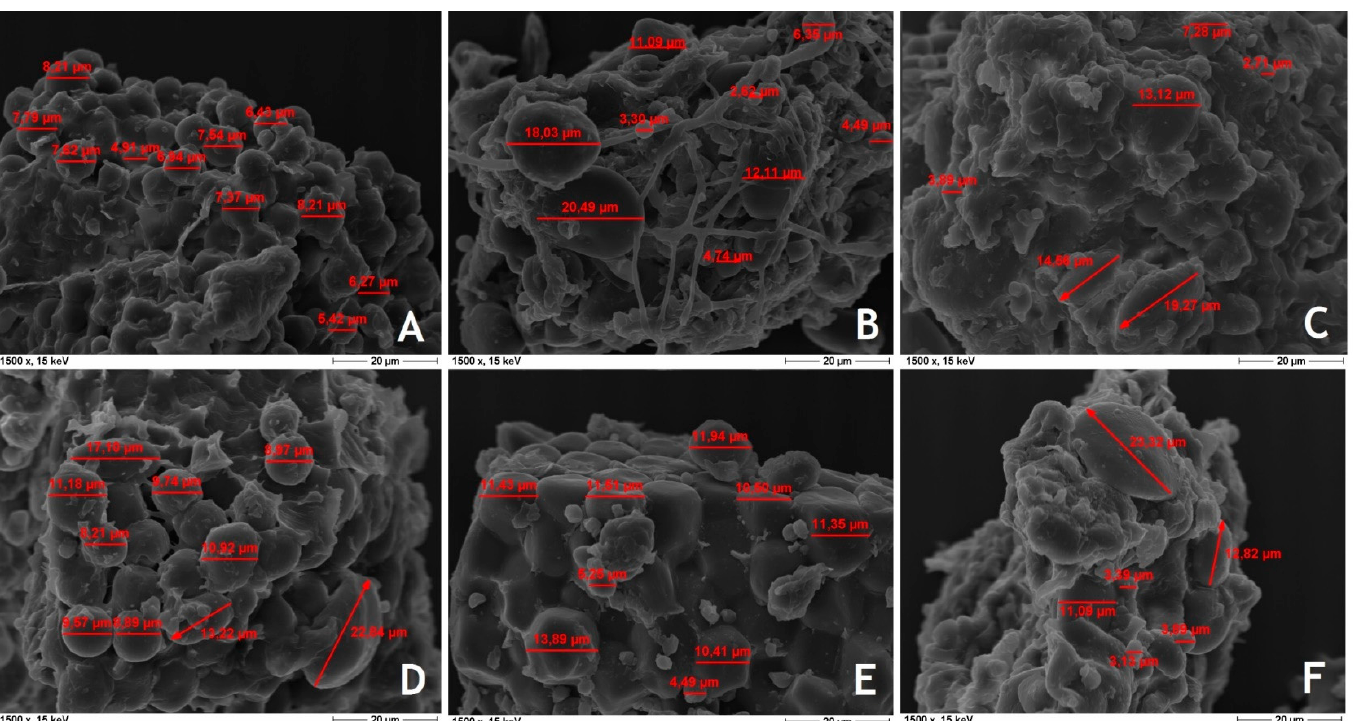
Figure 2. ESM picture from starch granules of broiler feed ( × 1500) (( A ) coarsely ground non-compacted; ( B ) coarsely ground and pelleted; ( C ) coarsely ground, expanded and pelleted; ( D ) finely ground non-compacted; ( E ) finely ground and pelleted; ( F ) finely ground, expanded and pelleted).